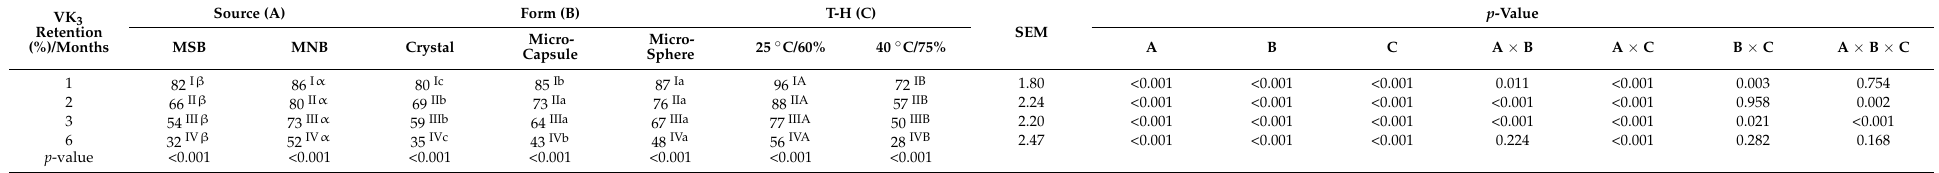
Table 3. Effects of sources and forms of vitamin K 3 , and temperature/relative humidity on the retention of vitamin K 3 in vitamin premixes.